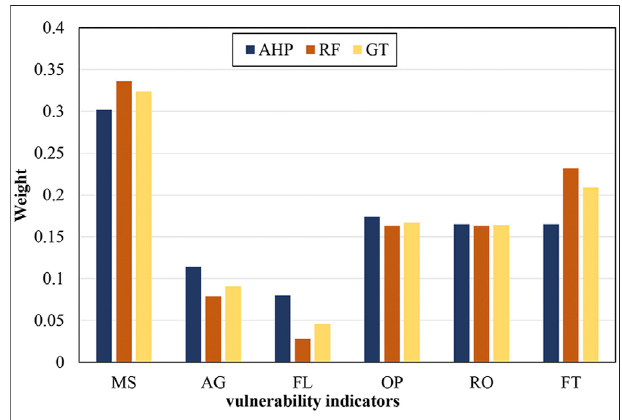
FIGURE 14 | Vulnerability indicator weights obtained by the three